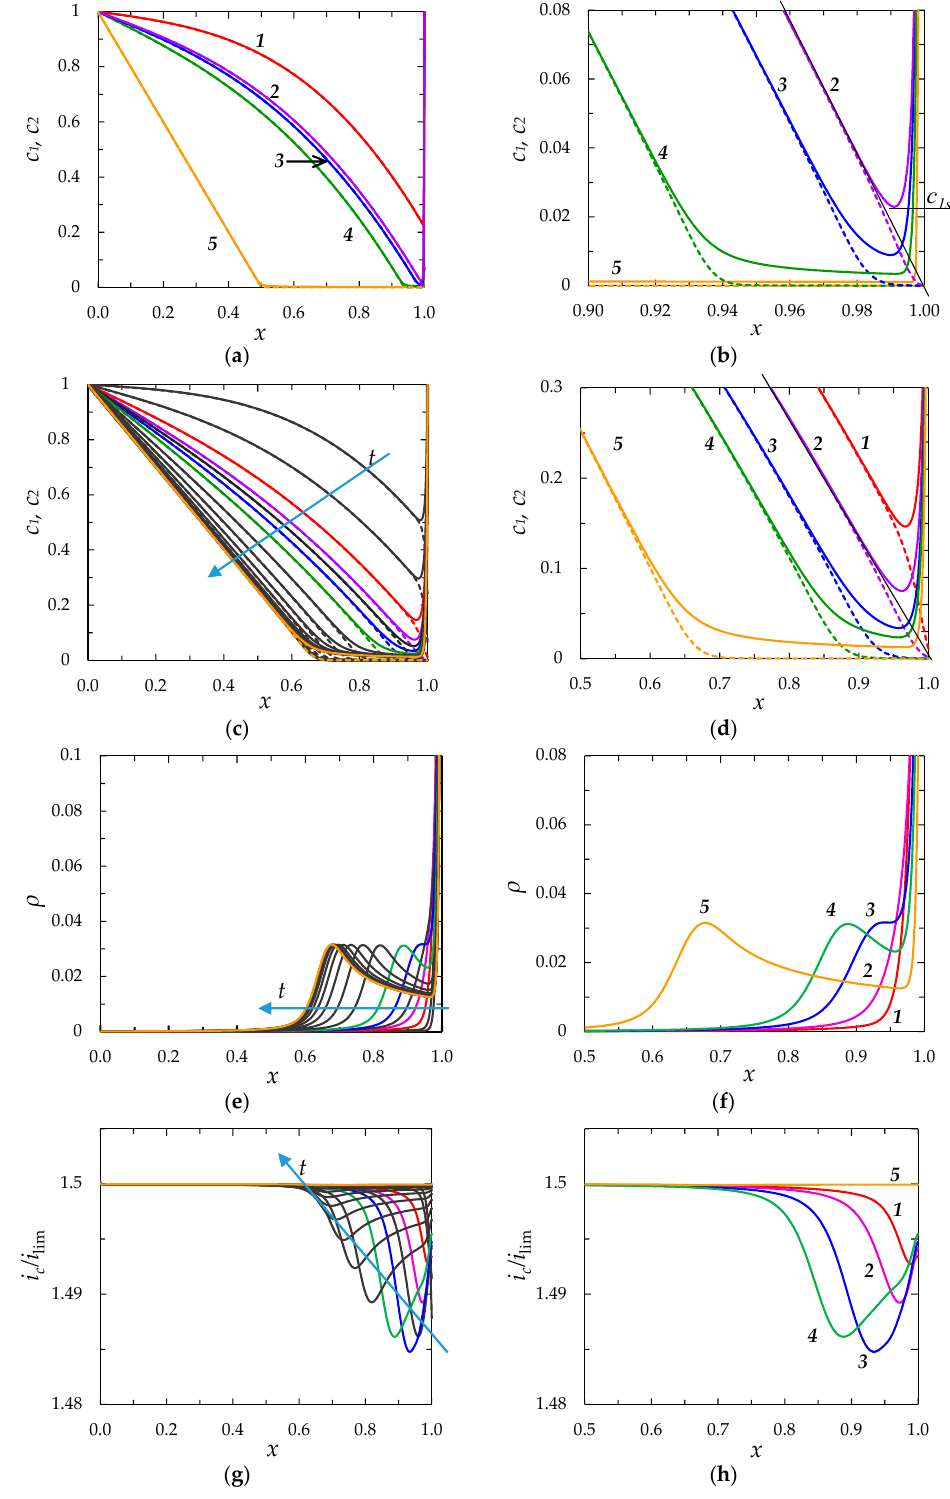
Figure 2. ( a , c ) Concentration profiles of cation ( c 1 , the solid lines) and anion ( c 2 , the dashed lines); ( b , d ) enlarged fragment of ( a , c ), respectively; ( e ) distribution of the dimensionless space charge density, ρ = z 1 c 1 + z 2 c 2 ; ( f ) enlarged fragment of ( e ); ( g ) distribution of the dimensionless conduction current density, i c /i lim ; ( h ) enlarged fragment of ( g ). ( a , b ) show numerical calculations at t = 0.119 (1), 0.197 (2), 0.208 (3), 0.239 (4) and 0.621 (5) for ε = 3 × 10 − 7 , i/i lim = 2. ( c , e , h ) show numerical calculations at t = 0.1, 0.2, . . . 1.5; ( d , f , h ), at t = 0.3 (1), 0.368 (2), 0.442 (3), 0.5 (4) and 1.5 (5) for ε = 3 × 10 − 5 , i/i lim = 1.5. The other parameters are given in Section